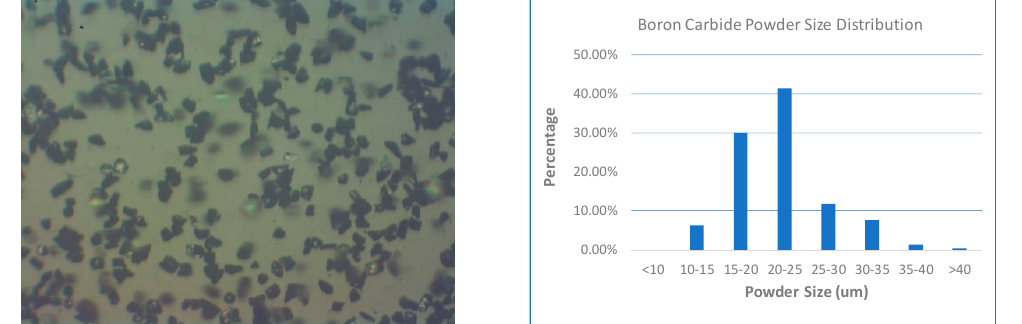
Figure 1. Characterization of boron carbide (B 4 C) powder.